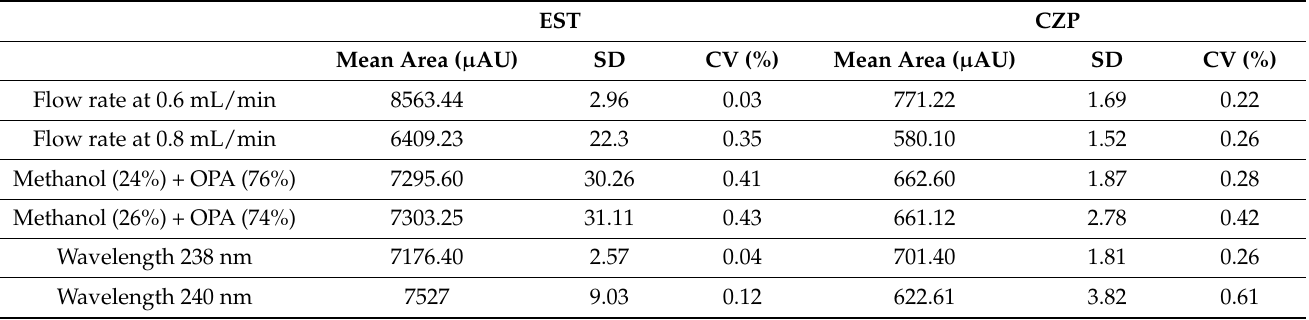
Table 4. Robustness